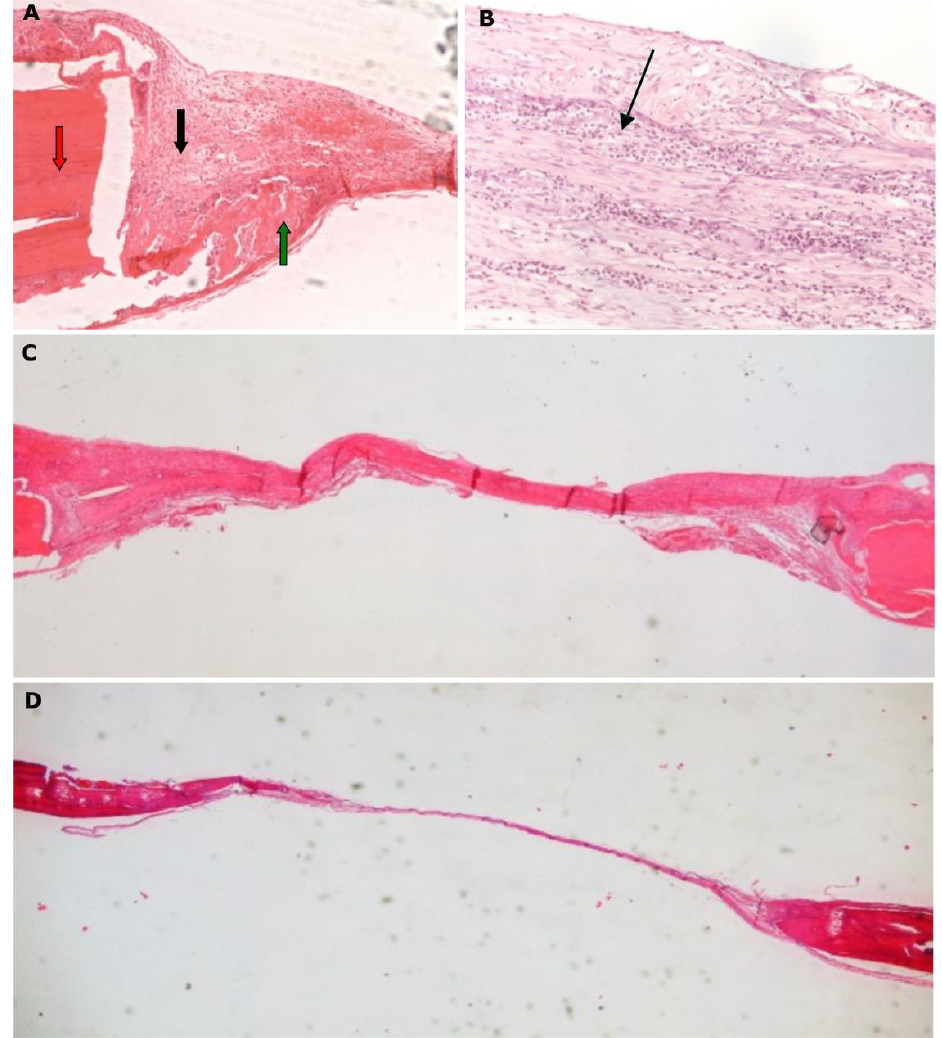
Figure 8. Histological micrographs of group DFS. ( A ) Group DFS1, magnification x200: limited new bone (green arrow) develops at the margins of the defect (red arrow), while significant inflammation is also observed (black arrow); ( B ) Group DFS1, magnification x200: development of extended inflammation of the fibrous connective tissue in the center of the defect (black arrow); ( C ) Group DFS1, magnification x20:, growth of dense fibrous connective tissue; ( D ) Group DFS2, magnification x20: limited new osseous tissue, loose fibrous connective tissue.